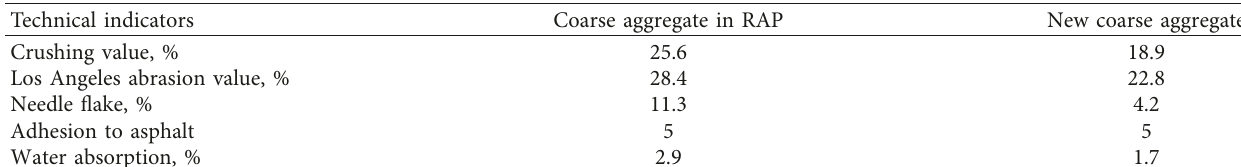
Table 4: Technical indicators of coarse